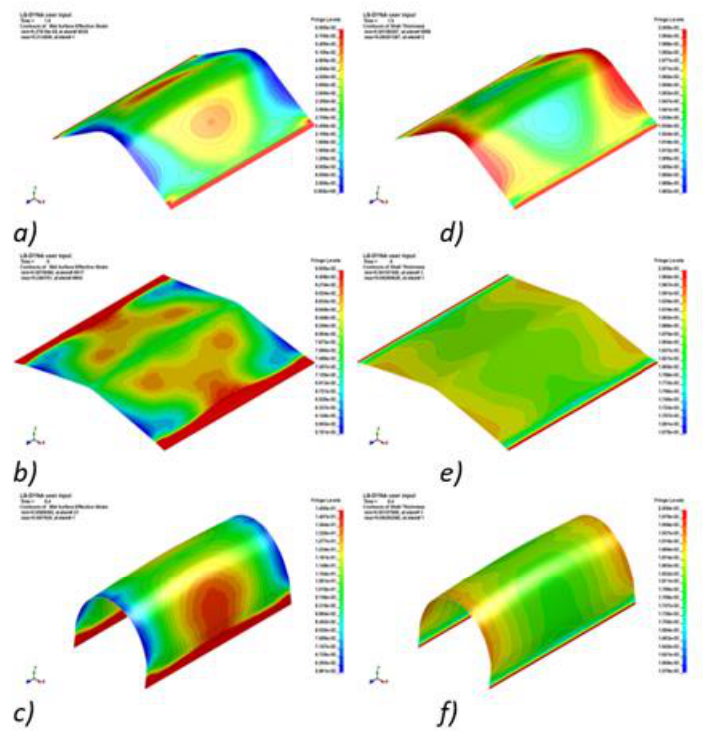
Figure 6. Distributions of experimental data 8 from the second kinematic scheme in the following stages: after the first skinning by an angle of 180 (a, d), after the workpiece has been bent by 120 and stretched (b, e), at the end of the molding operation (c, f); a, b, c - distribution of effective deformations along the middle shell surface; d, e, f is the shell thickness